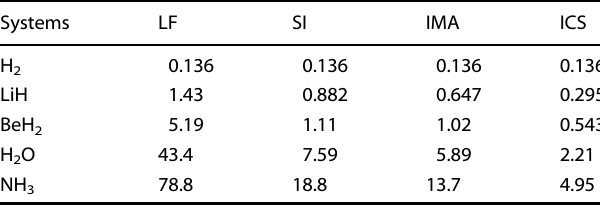
Variances of Hamiltonian estimators with fully commuting fragments: largest fi rst (LF), sorted insertion (SI), iterative measurement allocation (IMA), and iterative coef fi cient splitting (ICS). All algorithms utilize CISD wavefunctions for choosing parameters, but the fi nal variances are computed using exact